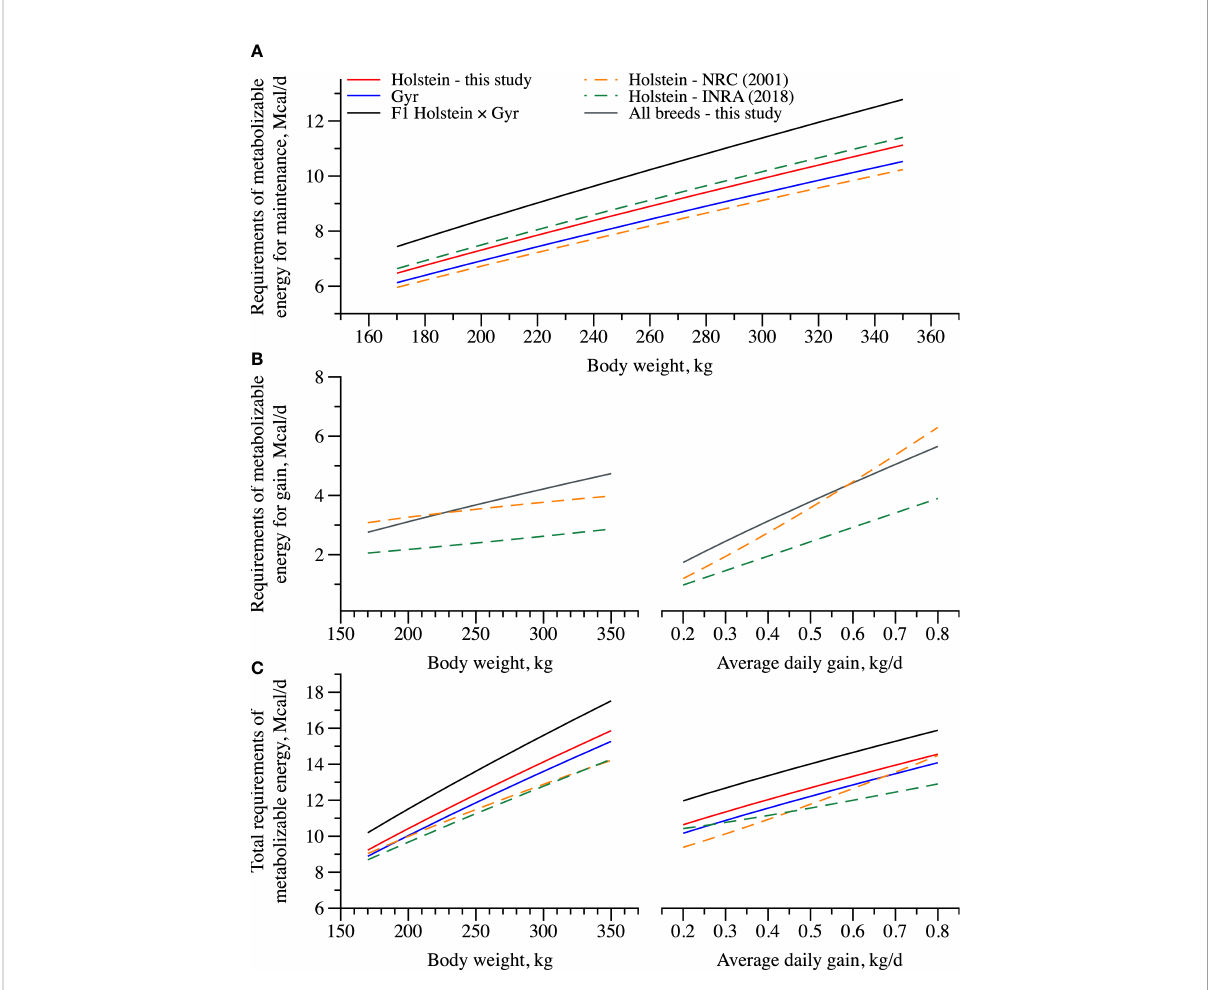
FIGURE 4 Total requirements of metabolizable energy of Holstein, Gyr, and F1 Holstein × Gyr dairy heifers estimated using a BW of 260 kg and an ADG of 0.5 kg/day, and by the models proposed by the INRA (2018) and the NRC